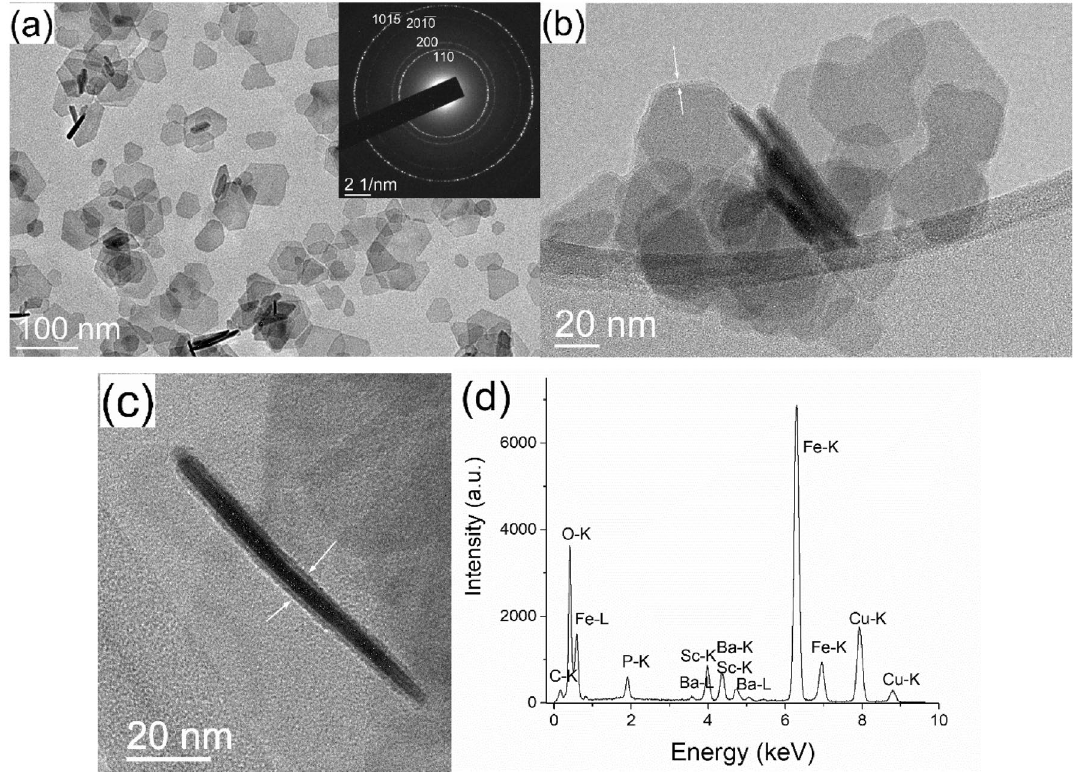
Figure 2. TEM images of the ( a ) as-synthesized BSHF NPLs with the corresponding SAED, ( b ) BSHF NPLs coated at RT with OPA and ( c ) EDTMP, and ( d ) the EDXS spectrum of BSHF NPLs@EDTMP. The indices in SAED correspond to the hexagonal space group P6 3 /mmc (194). The arrows in panels ( b ) and ( c ) point at the amorphous surface layer.